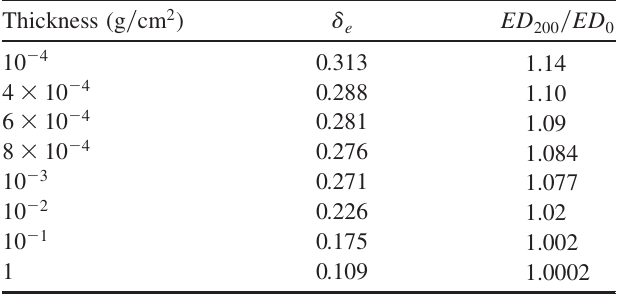
with 2 , calculated 2 =ED 200 0